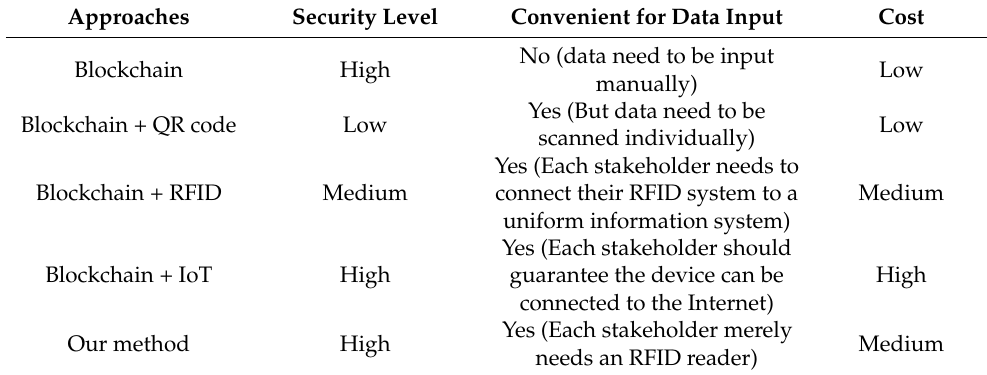
Table 3. Comparisons between different blockchain based methods for tracing and tracking